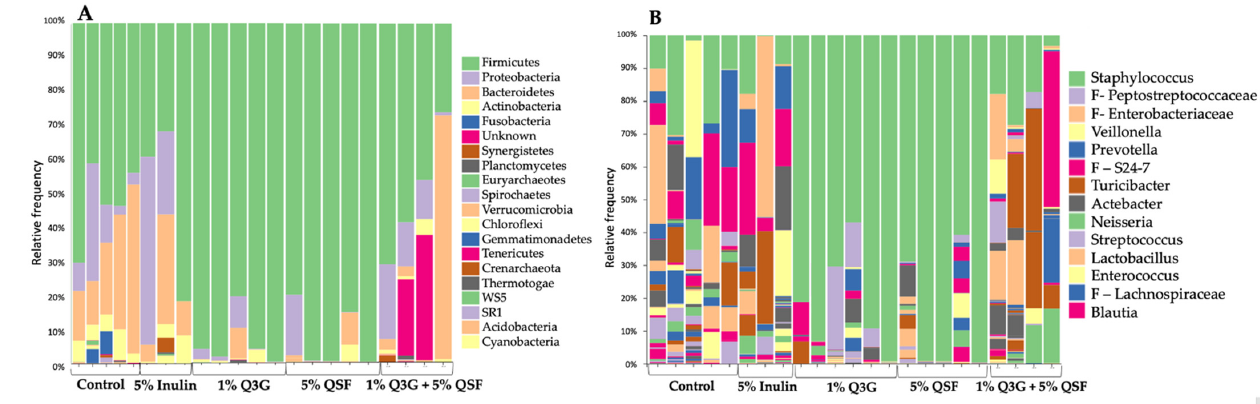
Figure 5. Compositional changes of the cecal microbiota in Gallus gallus following intra-amniotic administration. ( A ) Bacterial composition analysis at the phylum-level ( B ) Genus-level visualization of bacterial composition. F—family-level (when genus not known). Q3G, quercetin 3-glucoside; QSF, quinoa soluble fiber.